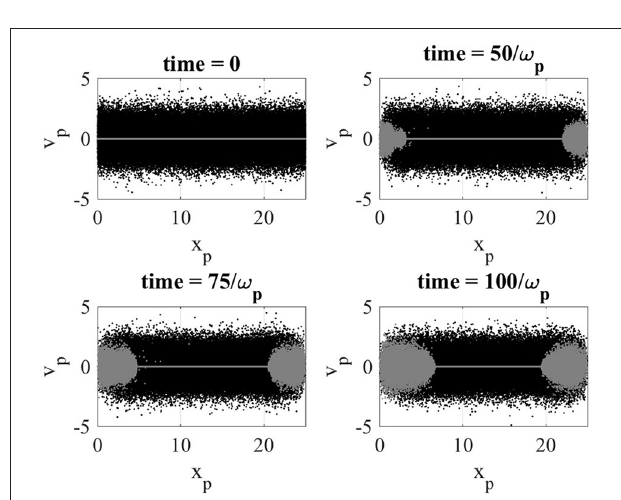
FIGURE 8 | Electron (black dots) and ion (gray dots) phase space in the sheath simulation. Initially all the electrons are kinetic and ions are fluid. If ion particle velocity becomes higher than 40 times the initial ion thermal velocity, the ion particle becomes kinetic. Fluid ion particles become kinetic in the sheath close L ). A video of phase space is available to the walls ( x 0 and x = =